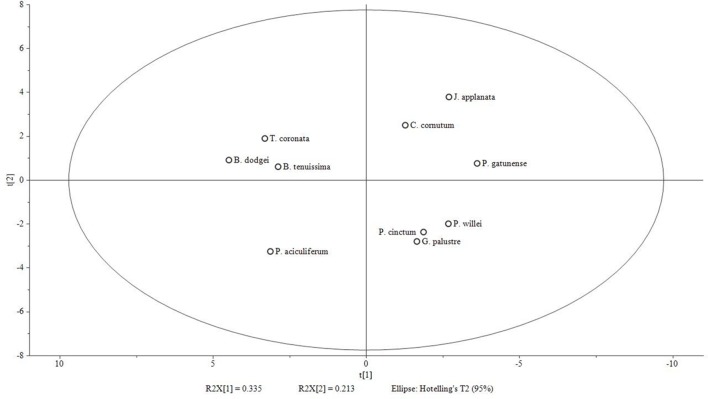
Score plot of PCA model based on % area of fatty acids [log(x+1) transformed and Pareto scaled] generated with Simca-P 13.0 software. 2 components; R2X (cumulative): 0.548; Q2 (cumulative): 0.104. Group 1 (left side of X-axis): B. dodgei, B. tenuissima, P. aciculiferum and T. coronata; group 2 (right side): J. applanata, C. cornutum, P. gatunense, P. willei, P. cinctum, G. palustre.